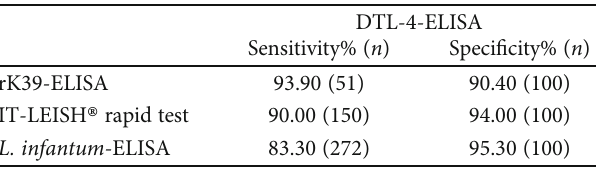
Table 2: Performance of DTL-4-ELISA in the diagnosis of VL according to the reference diagnostic test, like rK39-ELISA, IT- LEISH® rapid test, and L. infantum -ELISA (total